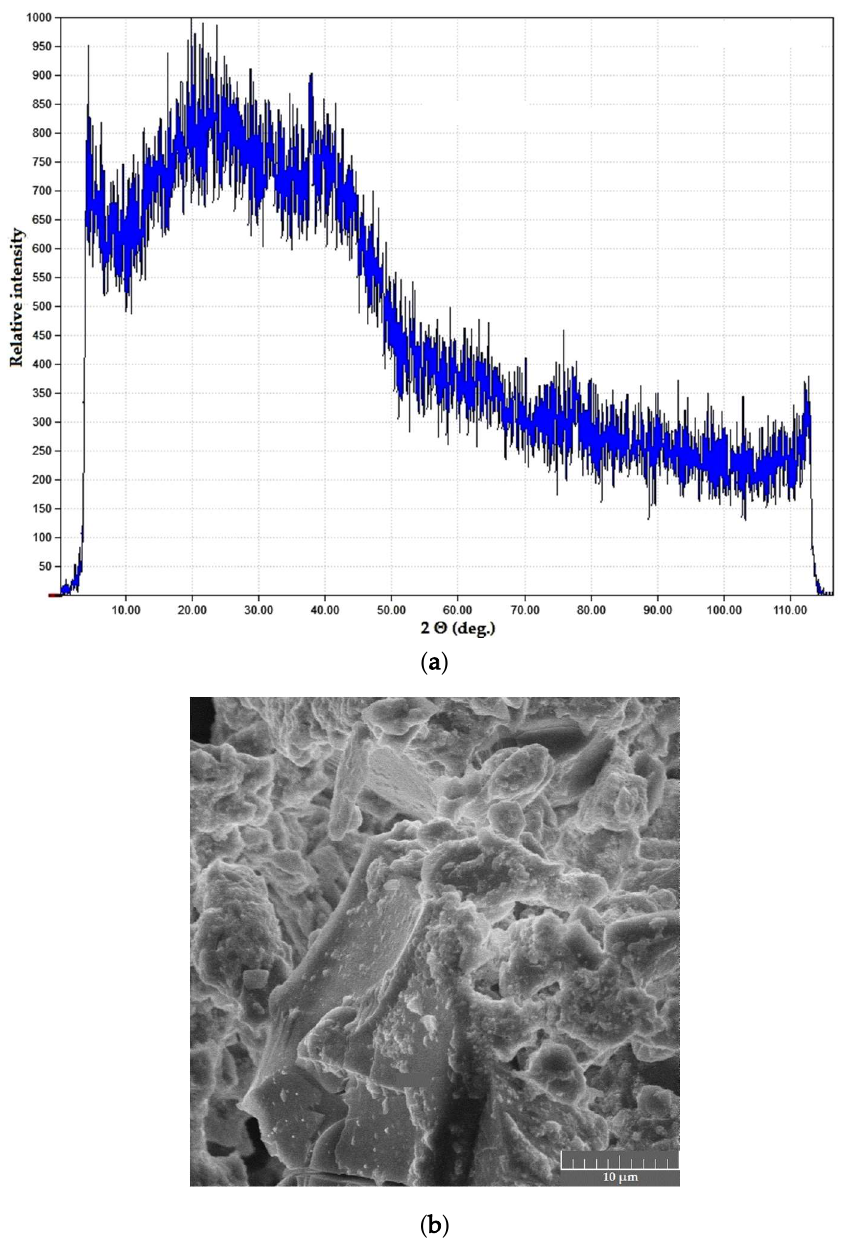
Figure 6. Dried products in the PVA–CAY system: (a) phase composition; (b) microstructure.